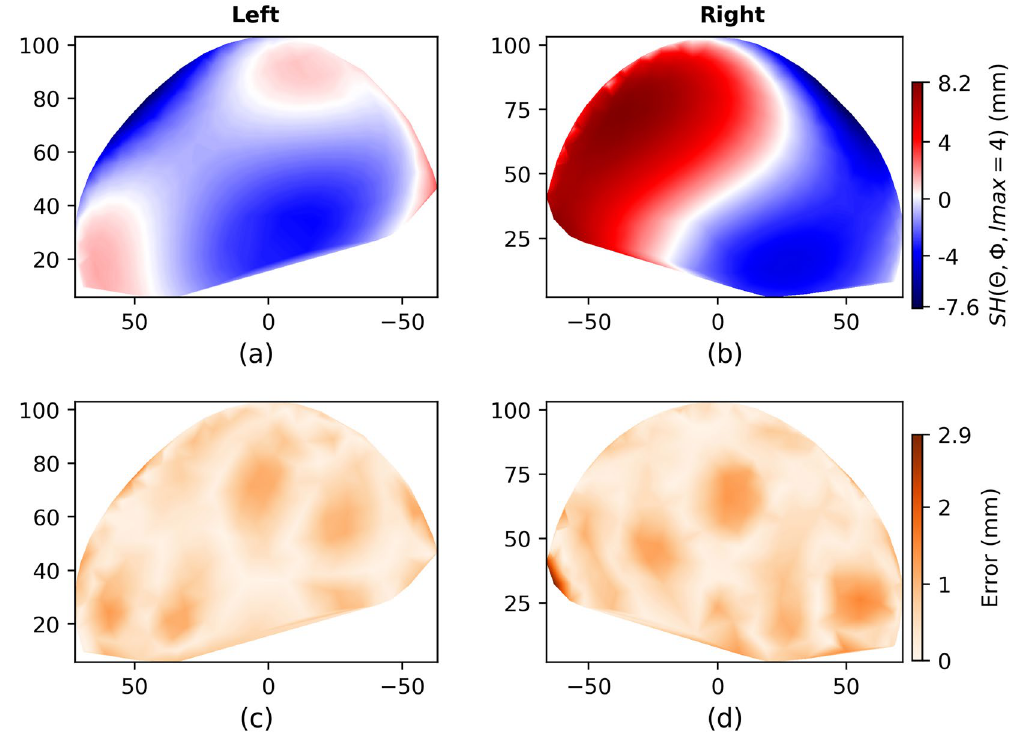
Figure 7. Patient P01: ( a , b ) are estimated differences to the fitted ellipsoid with spherical harmonics; ( c , d ) difference errors between the original photogrammetric 3D model and the spherical harmonics-based reconstruction. The RMSE for this patient was 0.62